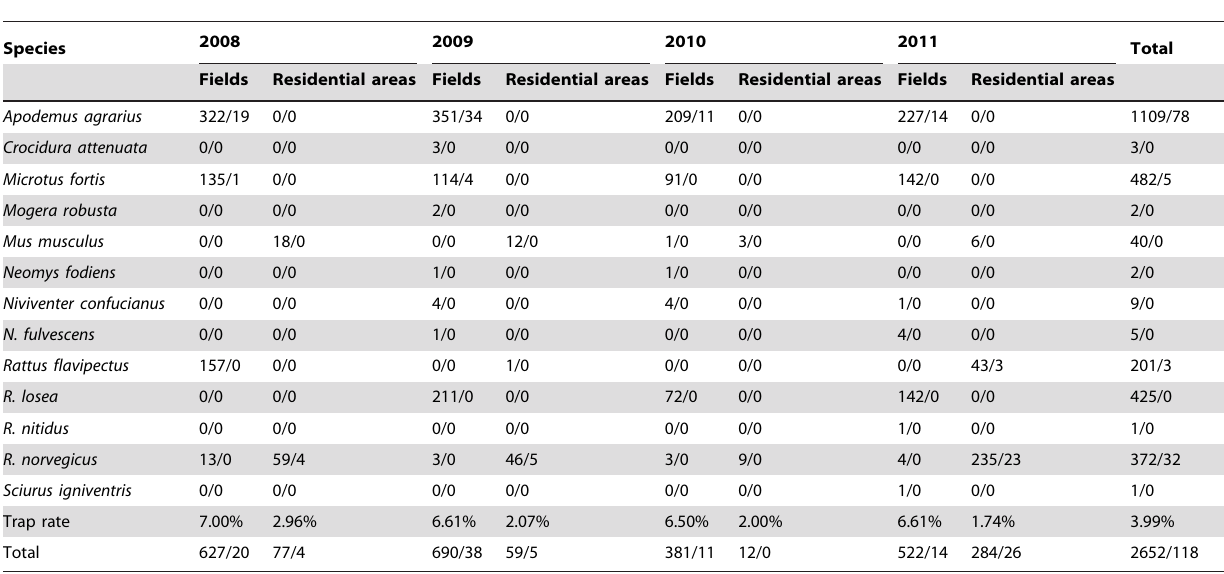
Table 1. Prevalence of hantavirus infection in small mammals in Longquan city, Zhejiang Province, China.